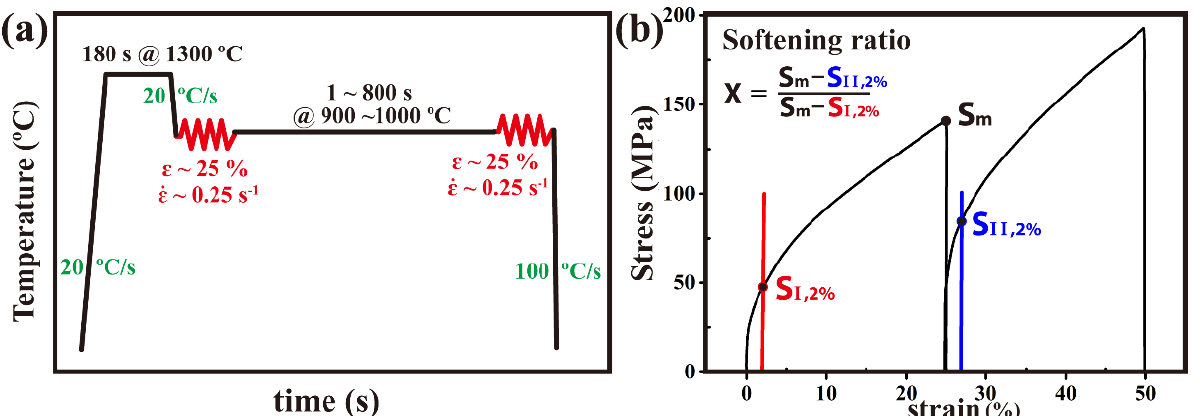
Figure 1. ( a ) Schematic diagram of thermo-mechanical treatment performed in the deformation- dilatometer. ( b ) Corresponding stress–strain curves obtained from the two compressive deformation processes. Softening ratio X can be determined by the 2% offset method.